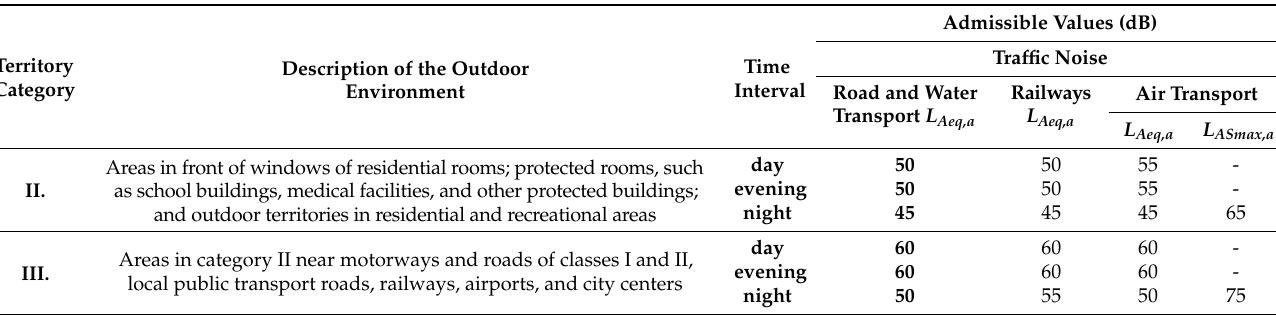
Table 1. The traffic noise admissible (a) values for selected outdoor territory categories